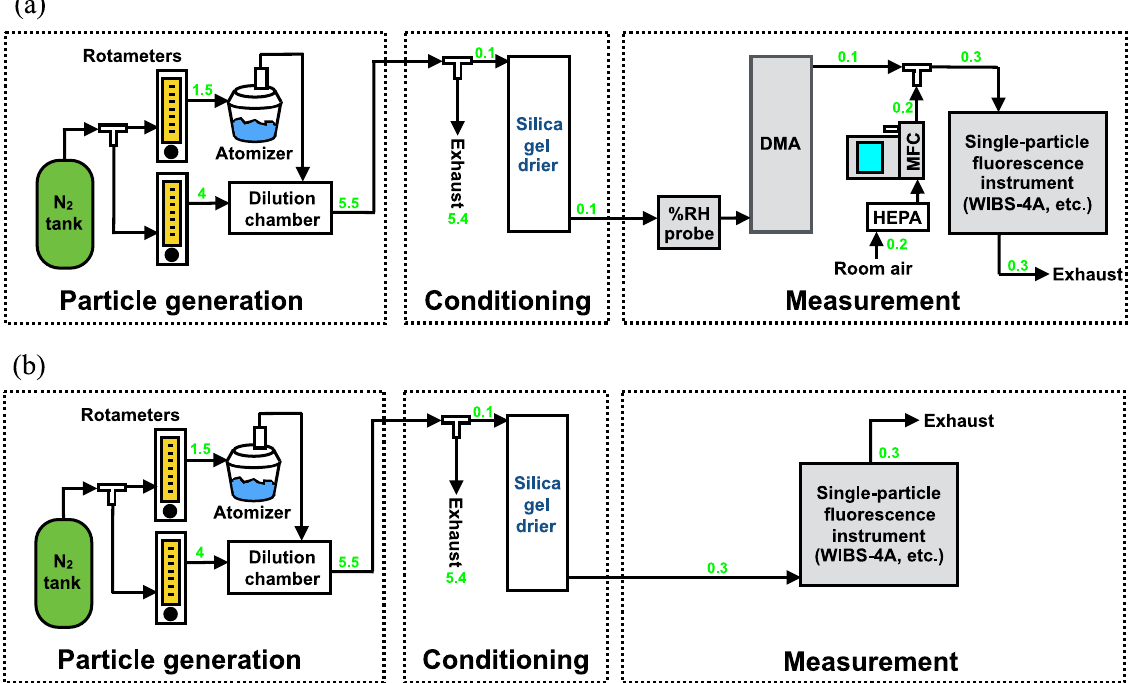
Figure 2. Experimental setup for fluorescent particle calibrations. Green numbers indicate flow rates in Lmin − 1 . (a) Size-selected calibration experiments. (b) Polydisperse calibration